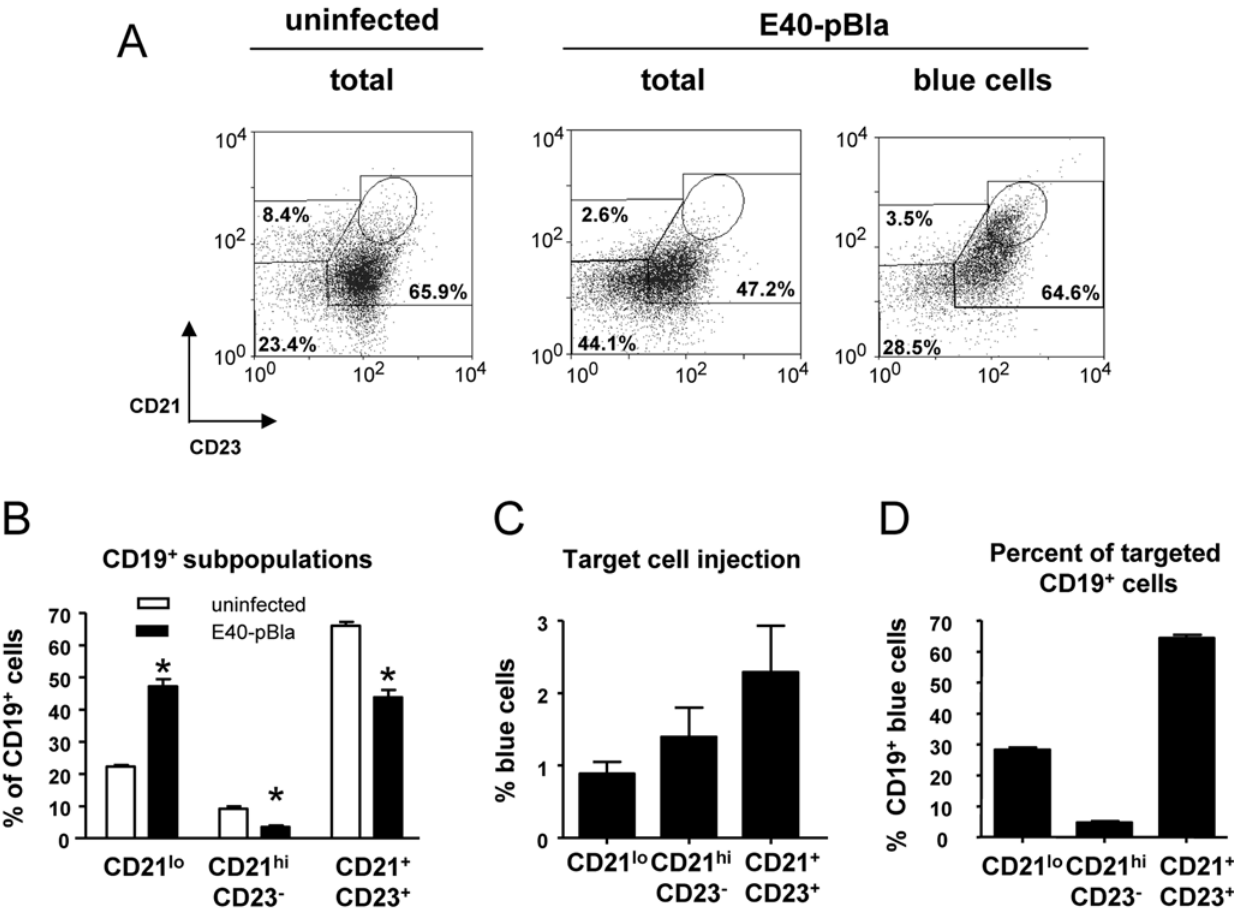
Figure 6. Determination of Yop injection in B cell populations. (A) Desferrioxamine conditioned mice were mock-infected or were infected with 5 6 10 5 E40-pBla for two days. Splenocytes were then stained with CD19-APC, CD21-PE-Cy7 and CD23-APC-Cy7 and with CCF-AM and then analyzed by flow cytometry. Cells were gated for viable CD19 + cells and then analyzed for expression of blue and green fluorescence as described in Figure S2. All viable CD19 + cells (total) or blue fluorescent CD19 + cells were then analyzed for CD21 and CD23 expression. CD21 hi CD23 2 cells were defined as MZ (marginal zone B cells), CD21 + CD23 + as FO (follicular B cells) and CD21 2 as NFB (newly formed B cells). In each diagram 10000 events are depicted. The percentage of each of these populations is indicated showing a representative experiment and percentages of the subpopulation are indicated for this experiment. (B) depicts the distribution of MZ, FO and NFB of CD19 + cells prior to and after infection of mice with E40-pBla. Asterisks indicate significant differences compared to uninfected (p , 0.05) (C) Mean and SEM of the percentage of blue cells for each CD19 + subpopulation. (D) shows the mean and SEM of the distribution of each subpopulation of all blue fluorescent CD19 + cells. In total four mice per group in two independent experiments were